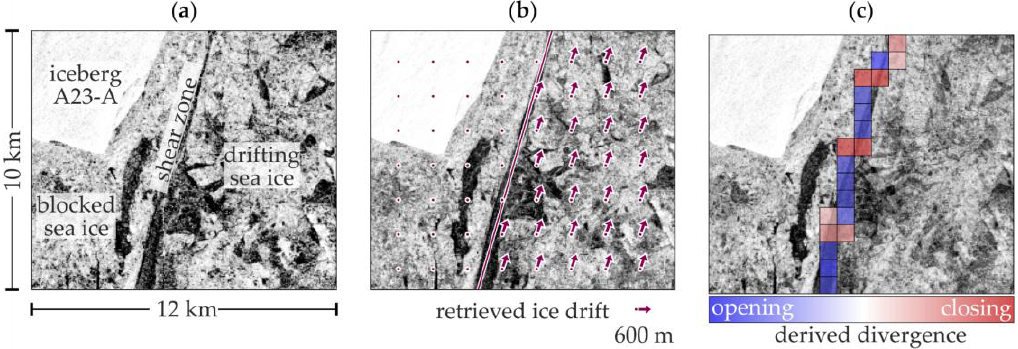
Figure 1. Envisat ASAR (Advanced Synthetic Aperture Radar) scene acquired in the Weddell Sea showing the artificial opening and closing as a result of the boundary definition error (BDE). ( a ) The ice on the left side is blocked by an iceberg; hence, a shear zone is formed between stationary and drifting ice. ( b ) Ice drift vectors determined with a pattern matching approach described in Thomas et al. [7]. ( c ) Divergence calculated from the drift vectors, revealing both opening and closing of the ice (although the expected divergence is zero).